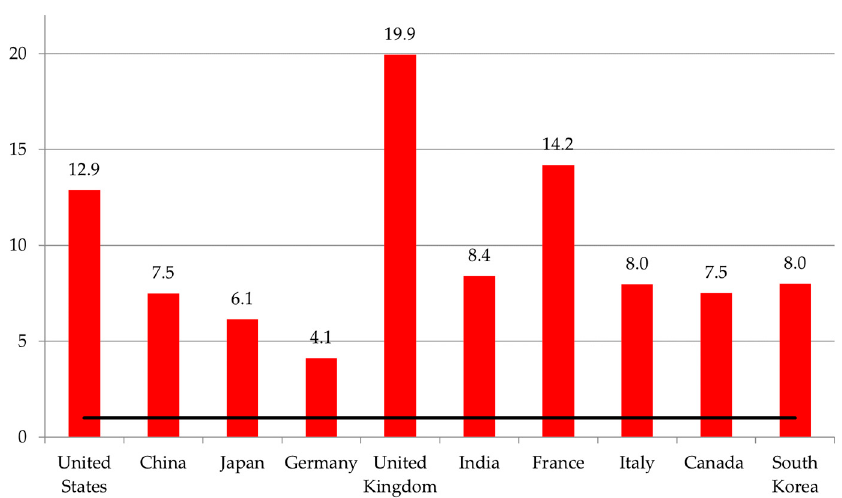
Figure 9. Relative magnitude of the GDP growth shocks for the top-10 world economies in 2020—border line presenting reference shock level (values above 1 indicate shocks).